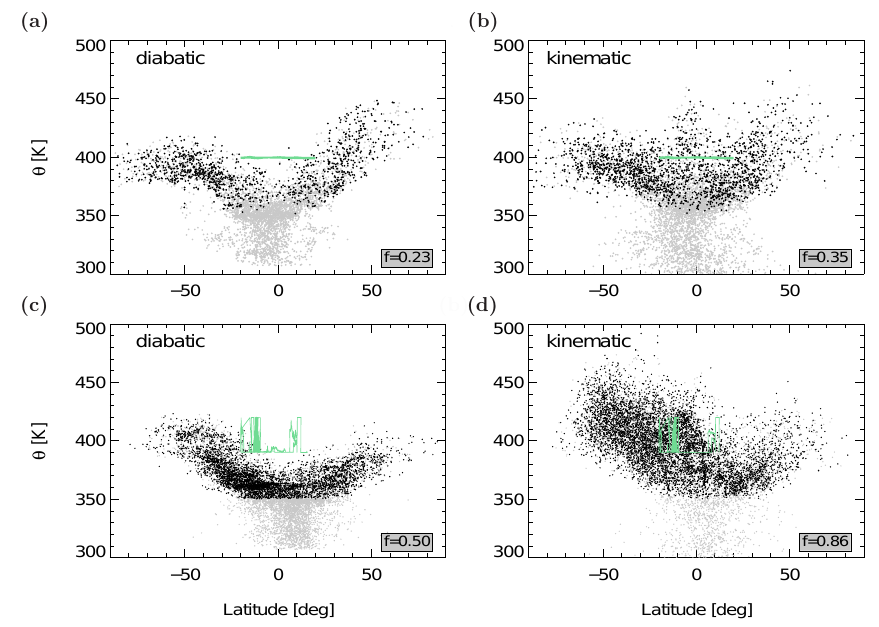
Fig. 5. (a/b) Locations of backtrajectories in the latitude/potential temperature plane 60 days prior to the start time (left: diabatic; right: kinematic), started on 400K potential temperature surface between ± 20 ◦ . End points of stratospheric trajectories are in black, of TST trajectories (see text) in grey and the starting locations (400K) in green. The number f denotes the fraction of stratospheric (non-TST) trajectories. (c/d) Same as (a/b) , but for SCOUT-O3